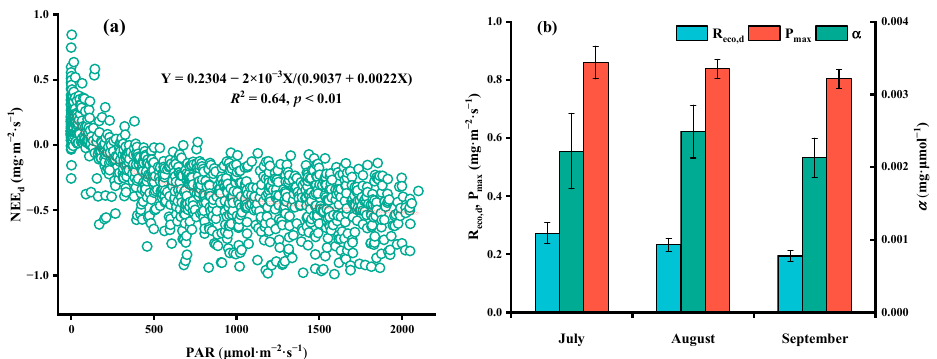
Figure 4. ( a ): The relationship between NEE d and PAR. ( b ): Monthly variation of the light response equation parameters.